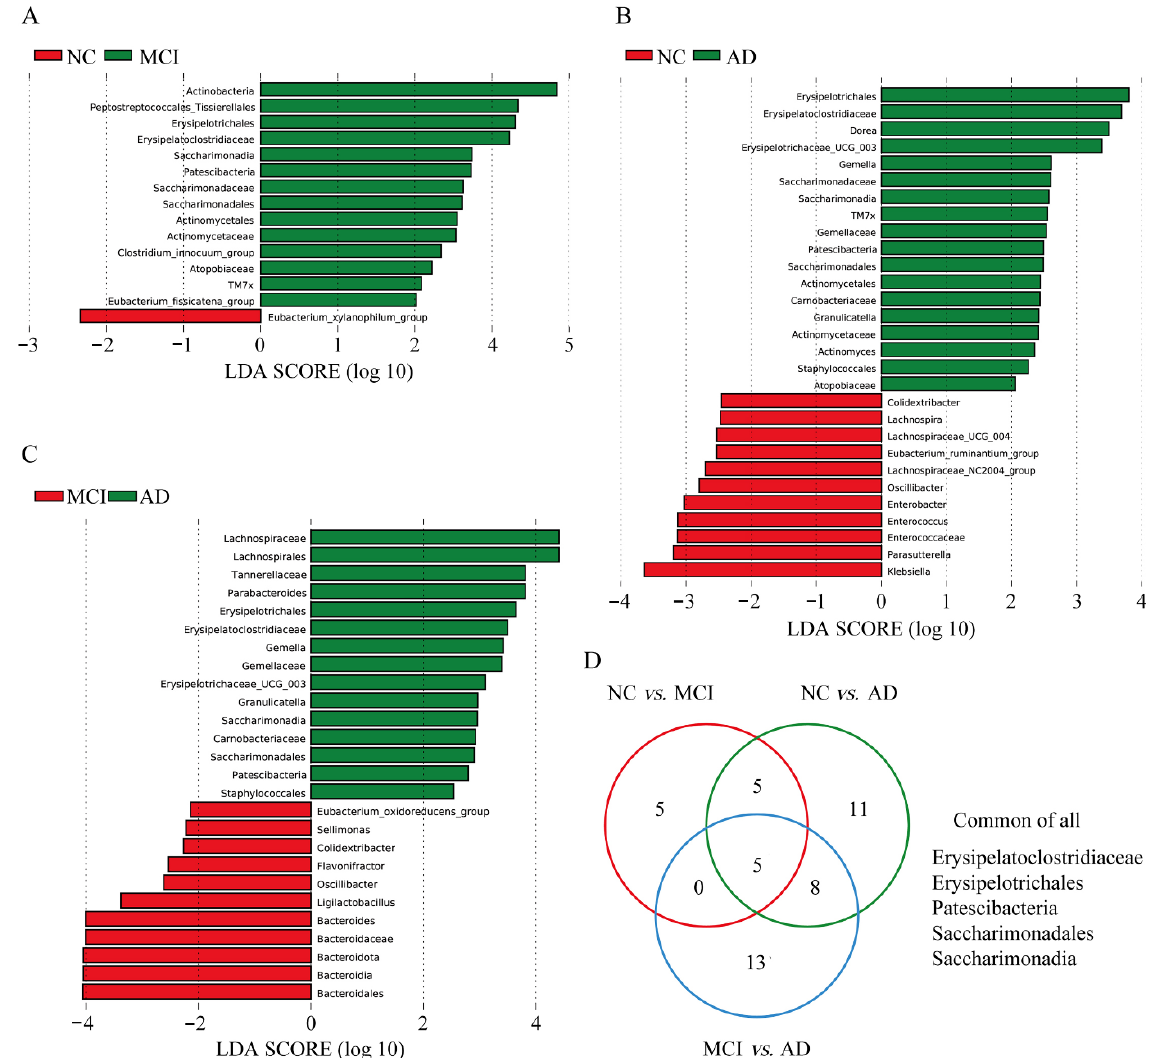
Figure 3. Bacterial taxa with different abundances among NC, MCI, and AD. ( A ) The differences of the LDA scores, histogram for bacterial genera between NC and MCI. ( B ) The differences of the LDA scores, histogram for bacterial genera between NC and AD. ( C ) The differences of the LDA scores, histogram for bacterial genera between MCI and AD. ( D ) Venn diagram of the genera showing the differences among the three groups. NC, cognitively normal controls; MCI, mild cognitive impairment; AD, Alzheimer’s disease; LDA, linear discriminant analysis.